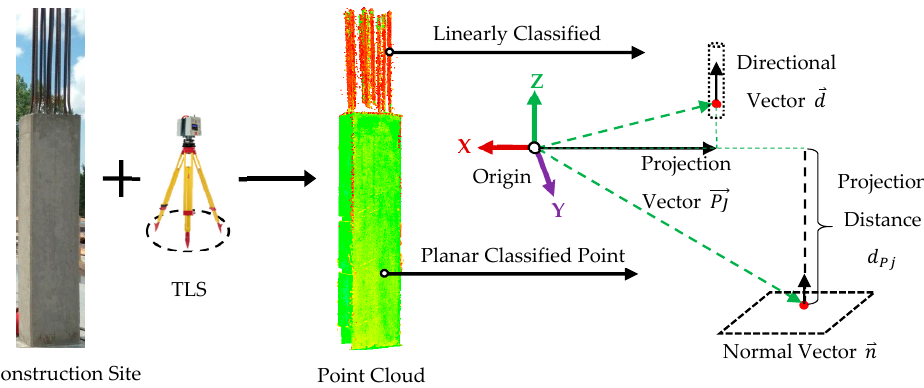
Figure 2. Attributes used to define linear and planar segments.